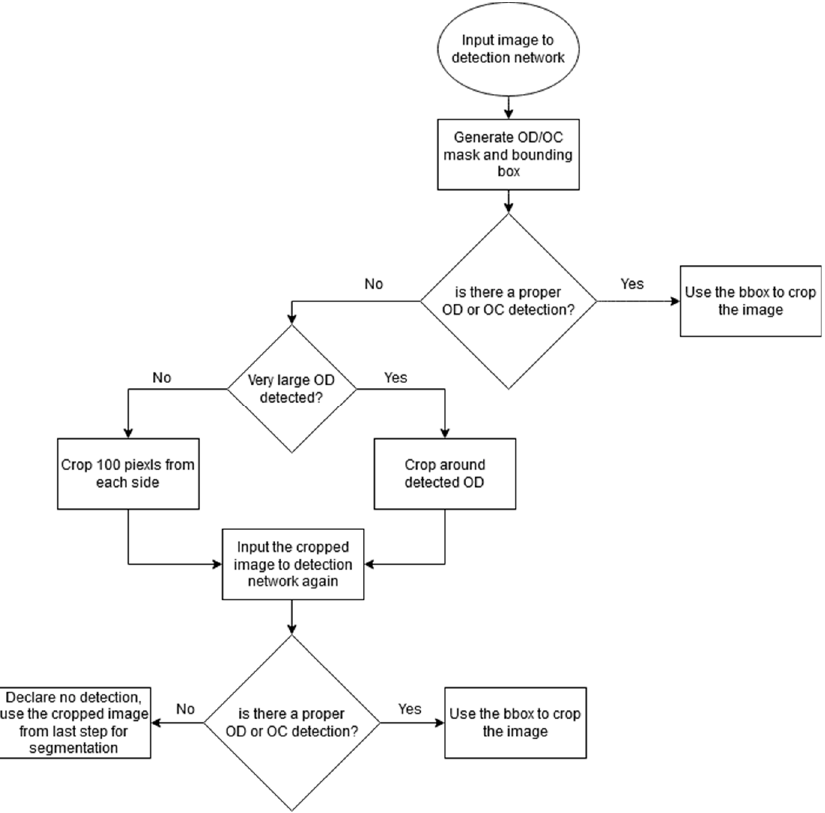
Figure 7. ONH detection flow using the trained detection network.